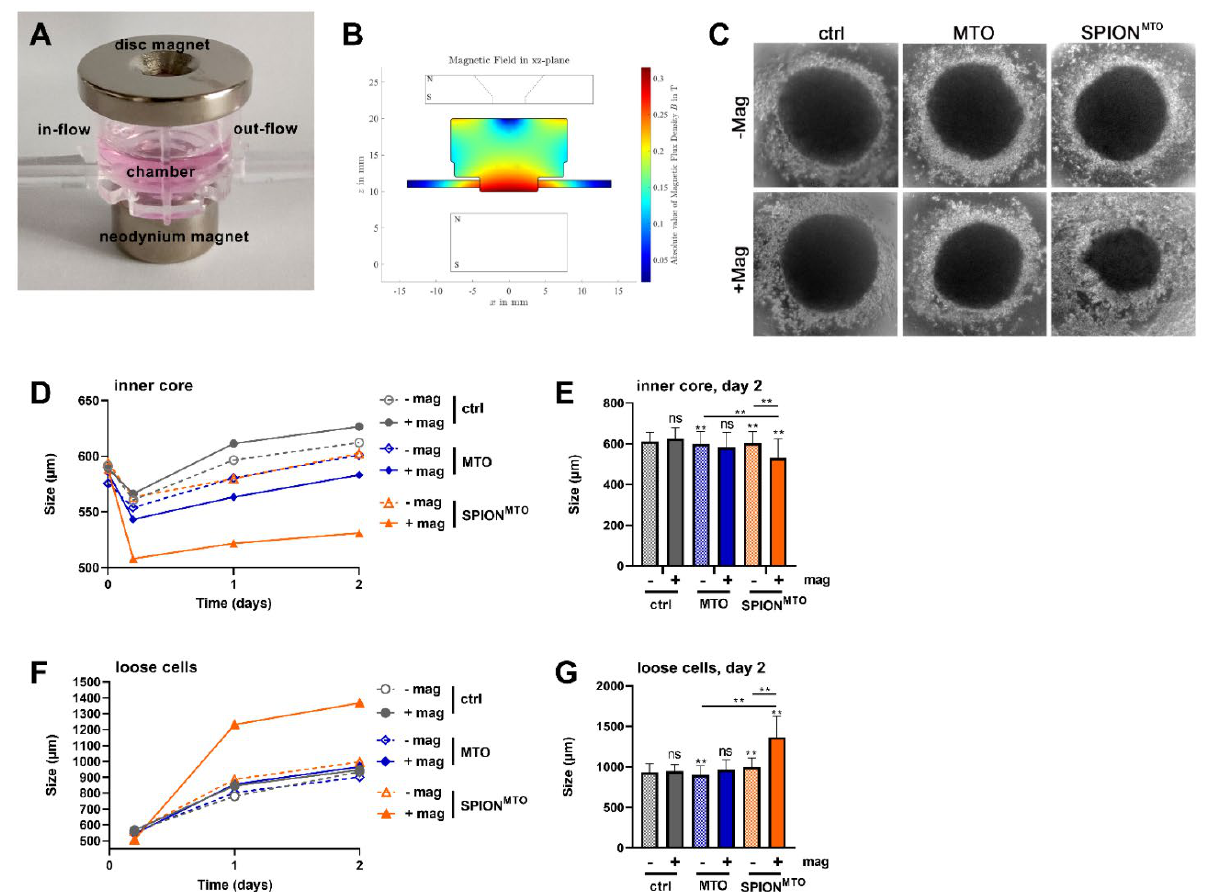
Figure 4. Magnetic accumulation of SPION MTO and effect on spheroids in a dynamic system. Spheroids were cultured for 3 days, and placed in a peristaltic pump connected to a MIVO ® chamber with two tubes. Free MTO, SPION MTO or unloaded SPIONs were pumped for 2.5–3 h with 1.08 mL/min in the presence or absence of a magnetic field ( A ). Simulation of the magnetic field in the chamber ( B ). Spheroids were harvested from the chambers, including the surrounding medium, then transferred into agarose-coated 96-well plates, and observed for 48 h in transmission microscopy ( C ). Pictures were analyzed using ImageJ software ( D – G ). The size of the compact inner core of the spheroid ( C , D ) was evaluated separately from the surrounding detached cells on day 2 ( D , E ). The experiment was performed three times, with 4–24 spheroids per condition ( D – G ). The mean values with standard deviations are shown. Significances were calculated using the two-way ANOVA test, with ** p ≤ 0.01, ns = non-significant ( E , G